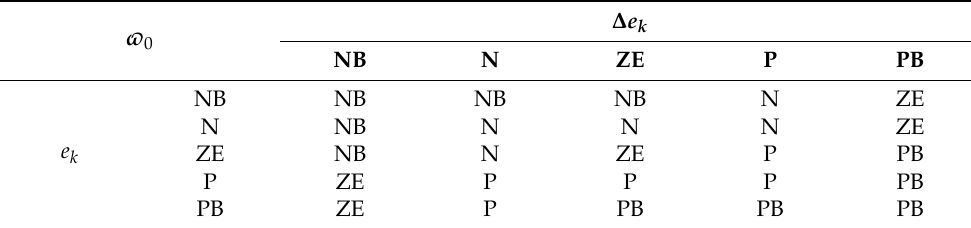
Table 1. Fuzzy rules for the (cid:118) 0 parameter’s tuning.